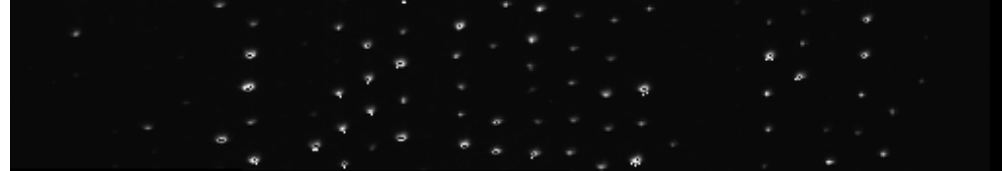
Figure 4. Resulting combined image of the overlap region that is produced by SimpleElastix (image turned by 90 ◦ clockwise). Field of view: 7.2 × 1.3mm 2